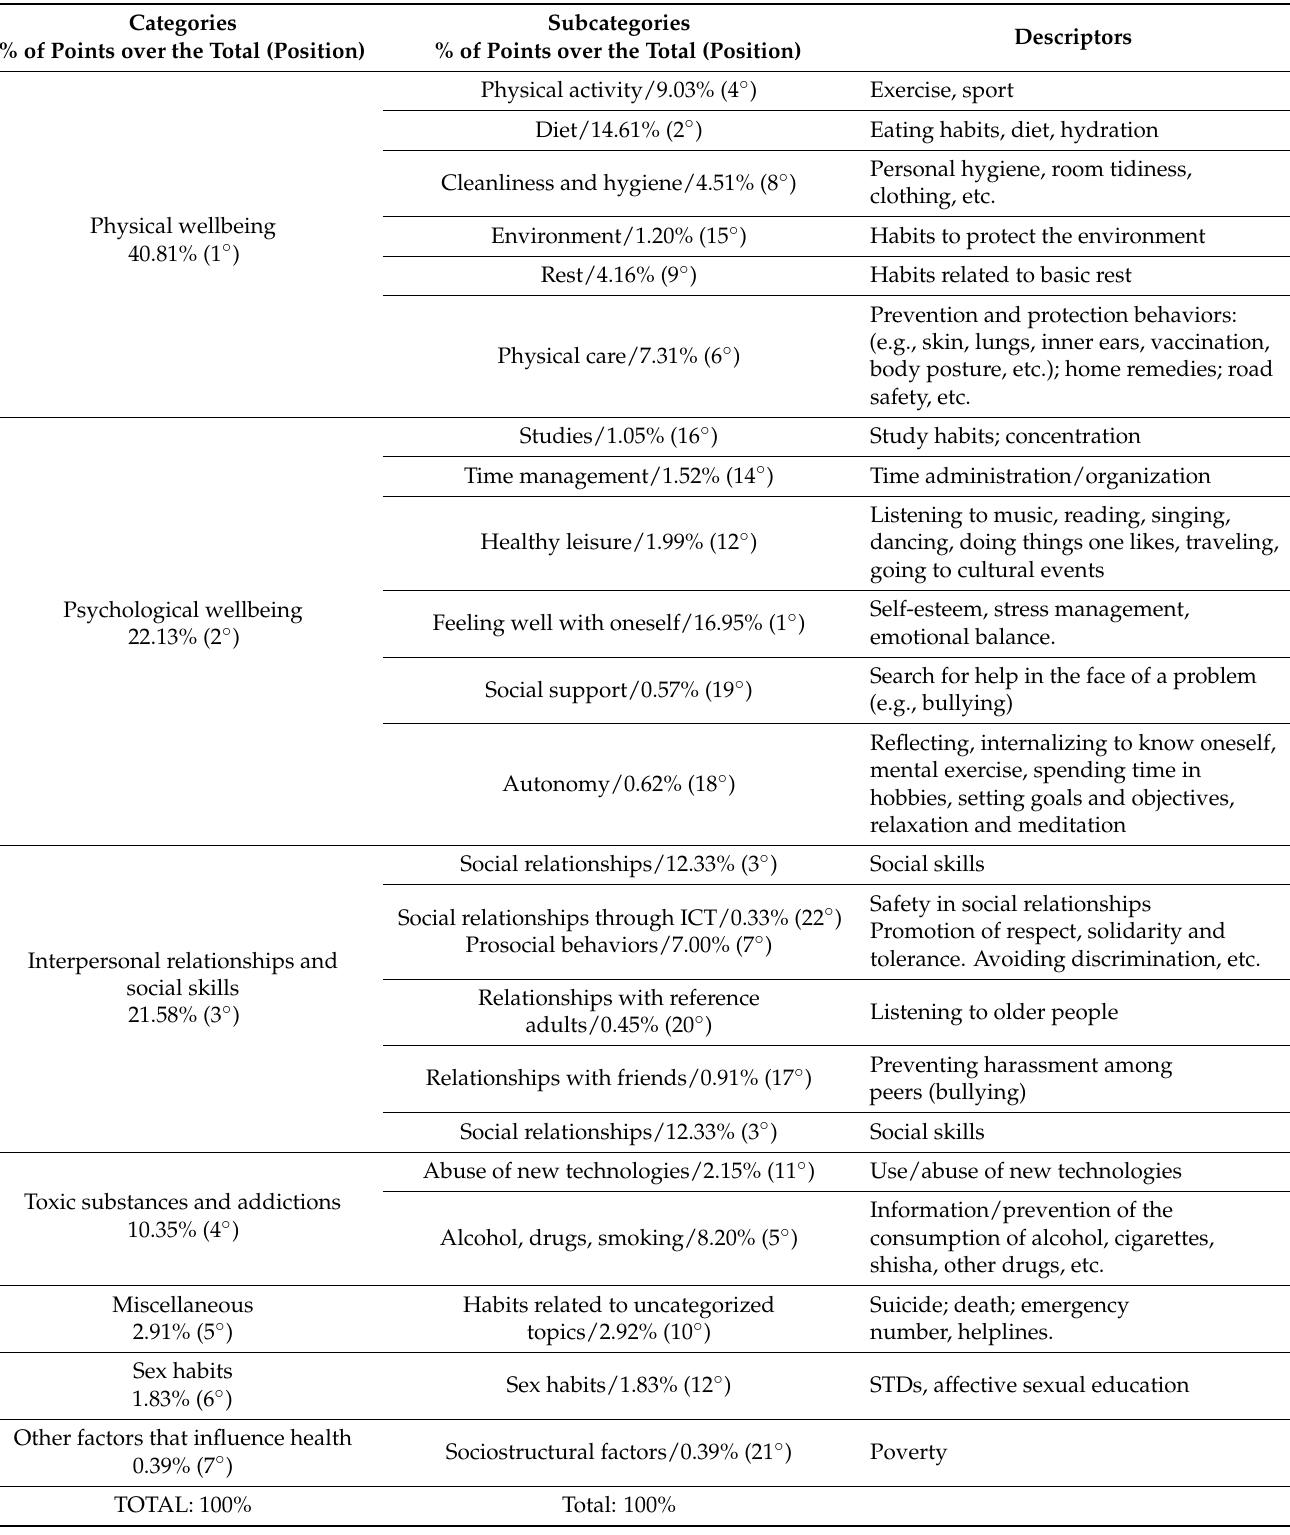
Table 1. Categories, subcategories and descriptors. Percentages of their obtained points and order of preference (calculated from the